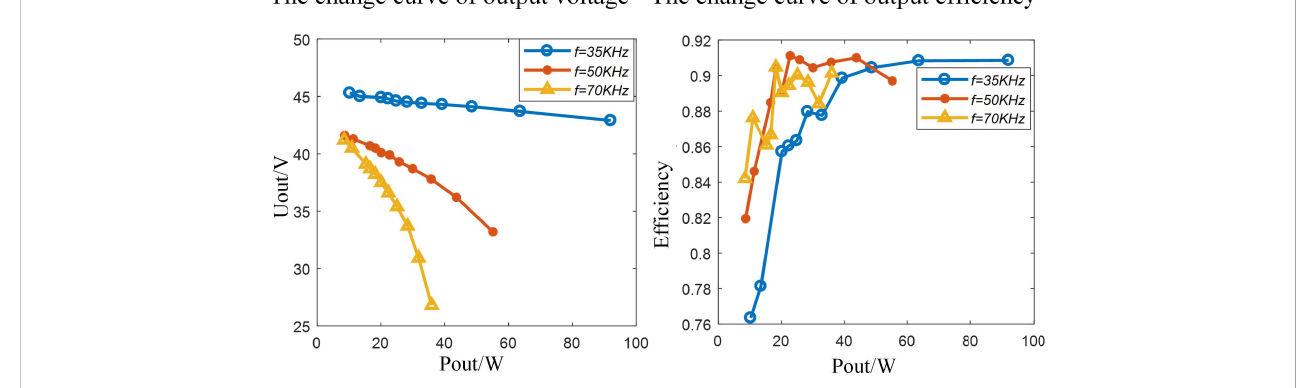
FIGURE 12 The power transmission performance of CLPT system.